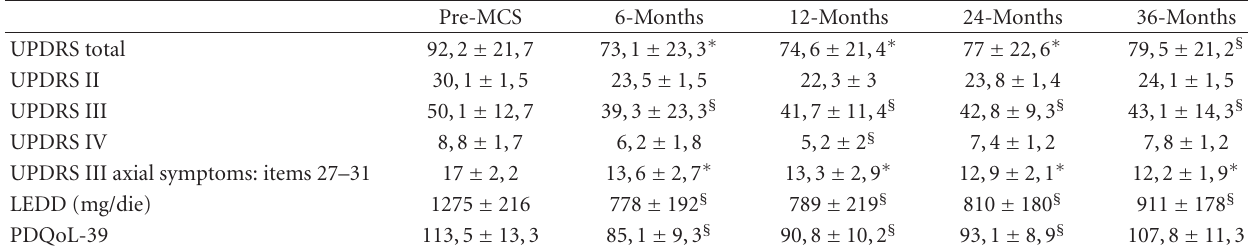
Table 1: Changes of quality of clinical assessment in ten patients with advanced Parkinson’s disease performed before motor cortex stimulation and after surgery at 6, 12, 24, and 36 months in o ff -medication/on-stimulation